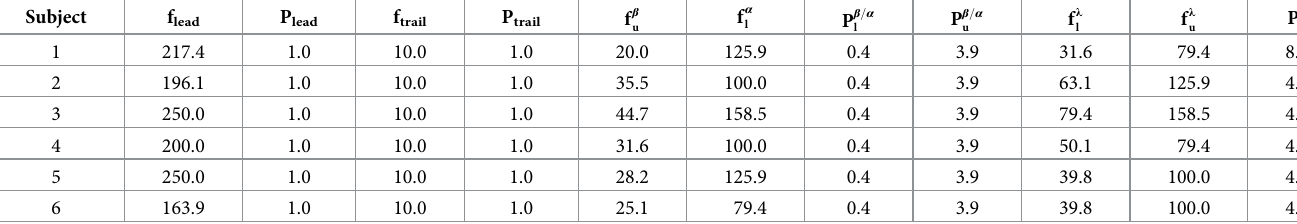
Table 2. Frequencies and prices used for lead and trail trials and for boundaries of regions α , β and λ